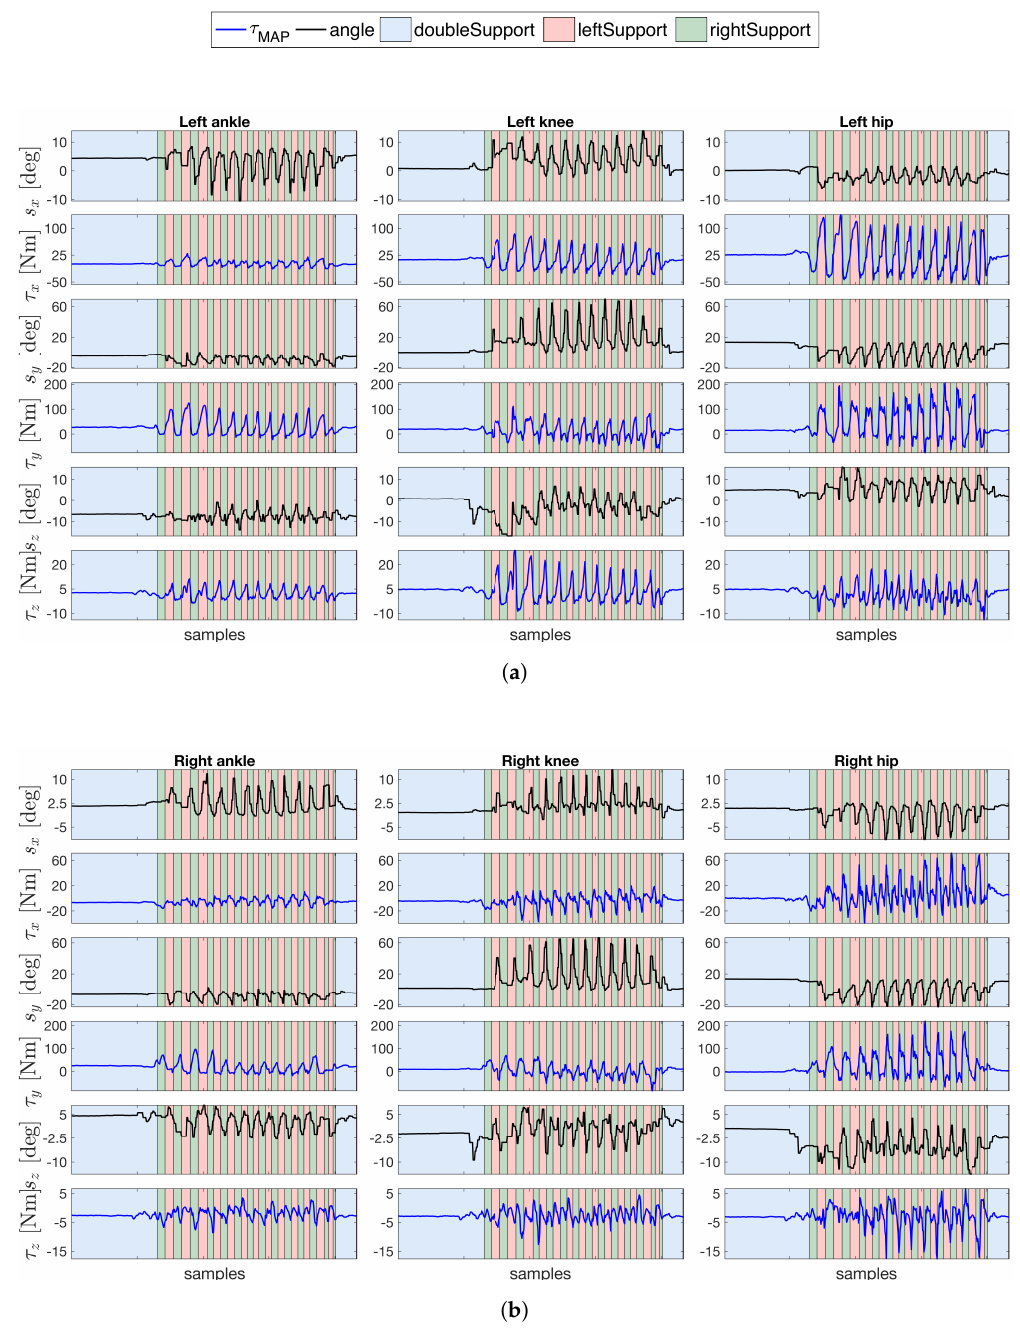
Figure 10. Floating-base MAP estimation in task T4 of the joint torques τ [ Nm] (in blue) for the ( b ) left leg and ( a ) right leg, respectively, along with the related joint angles s [deg] (in black). Gait estimations were performed by following the procedure for the feet contact classification in Algorithm